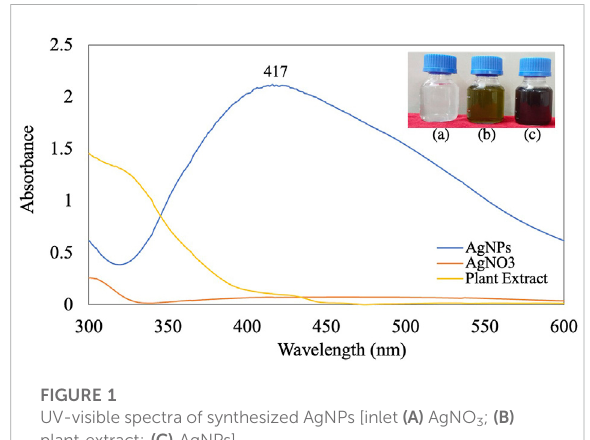
FIGURE 1 UV-visible spectra of synthesized AgNPs [inlet (A) AgNO 3 ; (B) plant extract; (C)